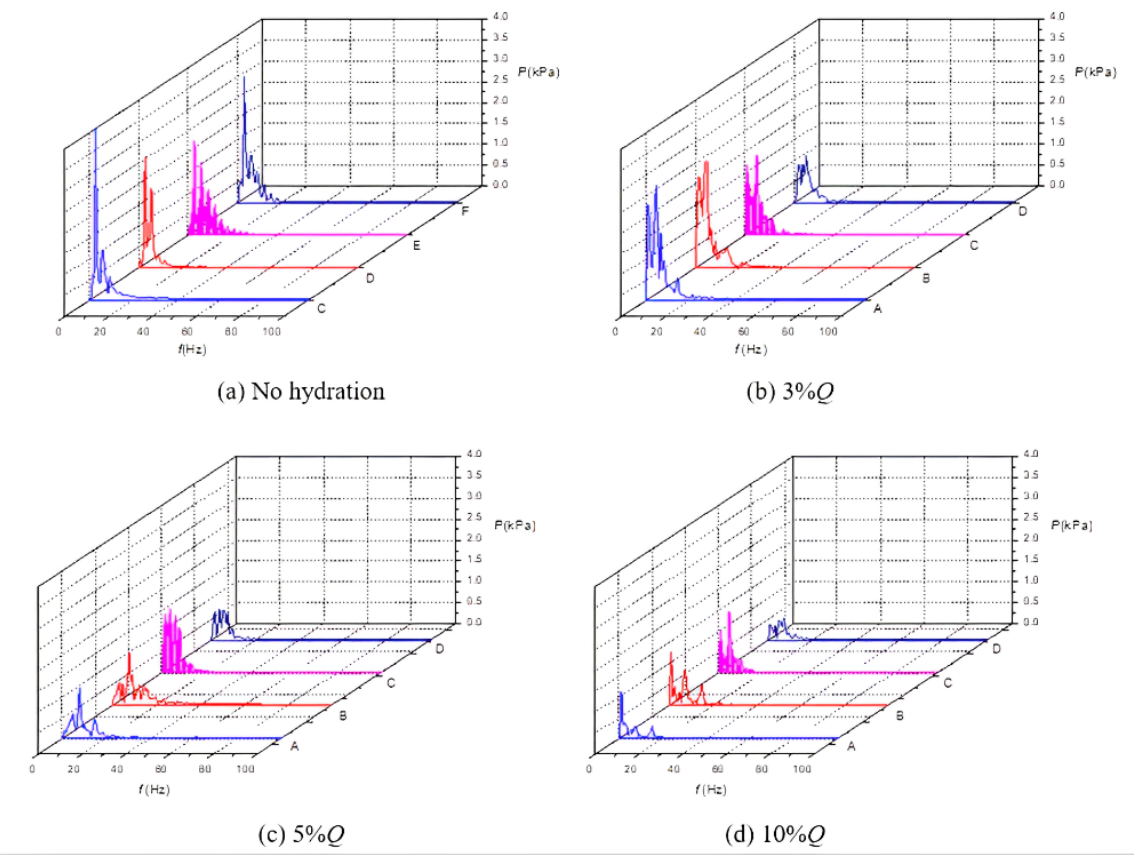
Figure 27. Frequency domain characteristics of draft tube monitoring points [38].